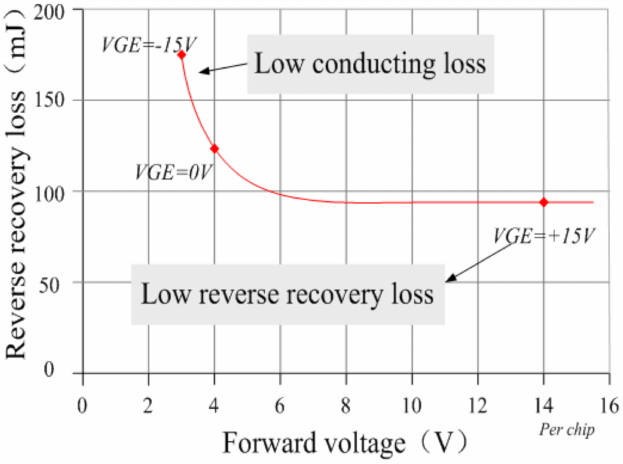
Figure 5. The influence of V GE on the conduction and reverse recovery of the body-diode [9].